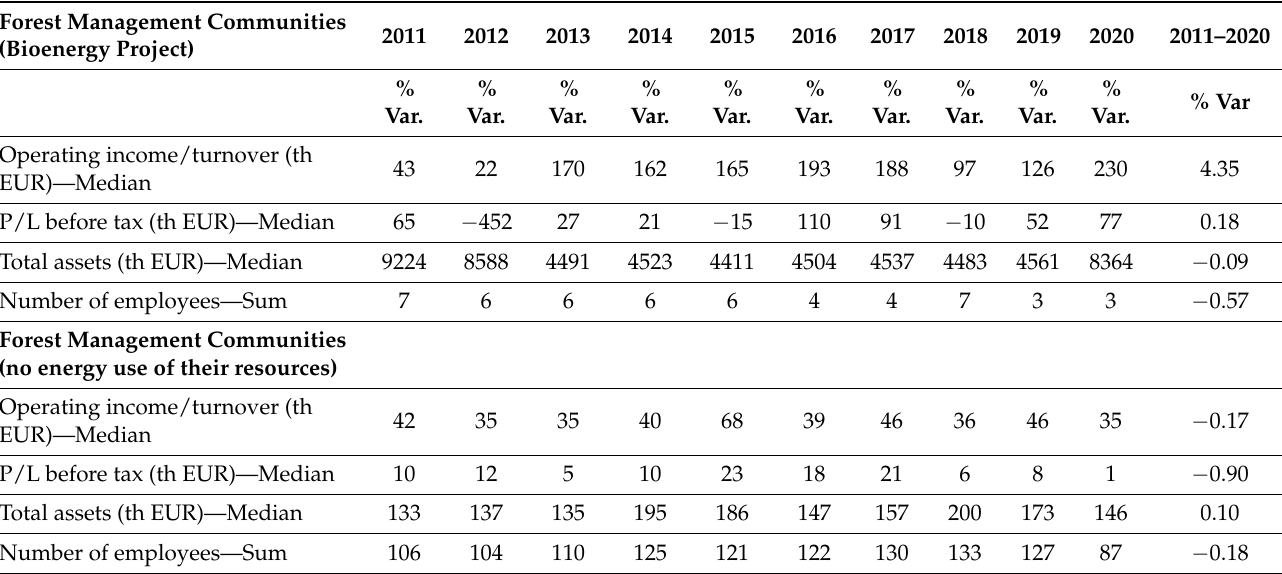
Table 4. Rates of change of the structural indicators of the two forest management communities’ groups at the aggregate level.